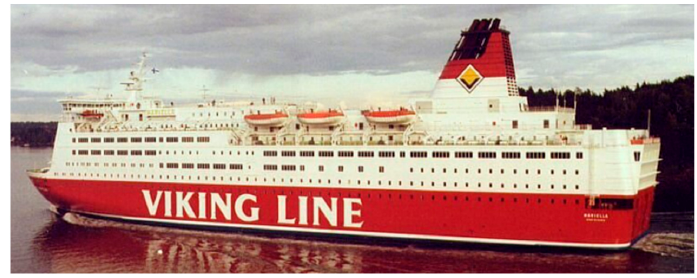
Figure 9. The passenger ship “MS Mariella” [64].